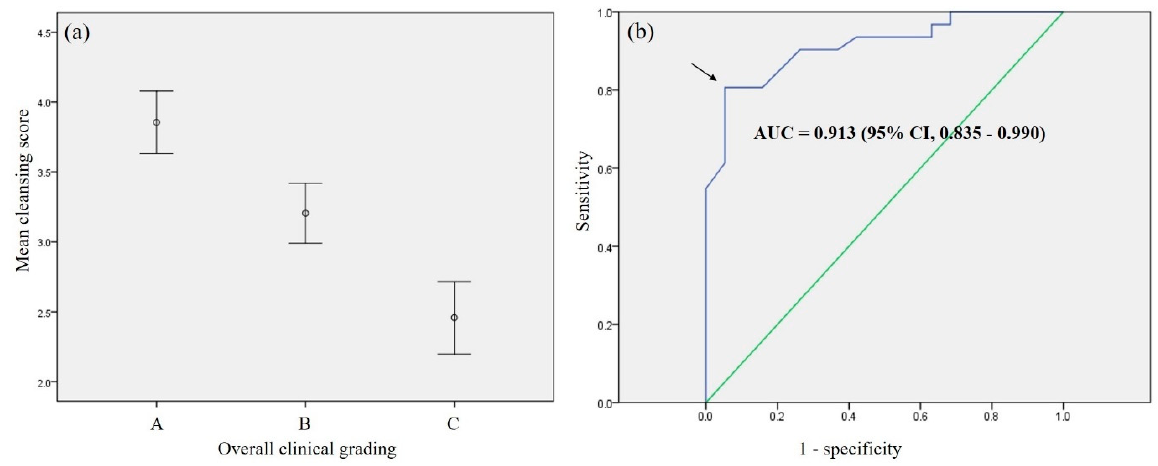
Figure 4. Outcomes of external validation. ( a ) Distribution of clinical grading and average cleansing scores of the validation cases; ( b ) Receiver operating characteristic curve of average cleansing score for clinically adequate preparation, indicating an estimated cut-off value of 2.95 (arrow). AUC, area under the curve.